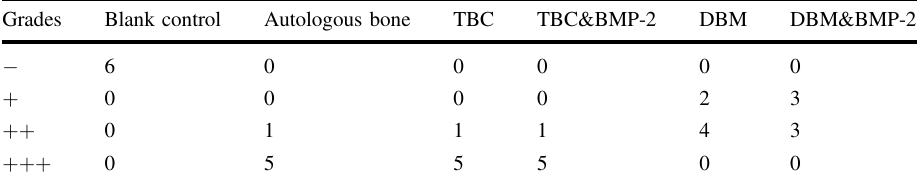
Table 1 Hitchcock grades count of femoral condyle